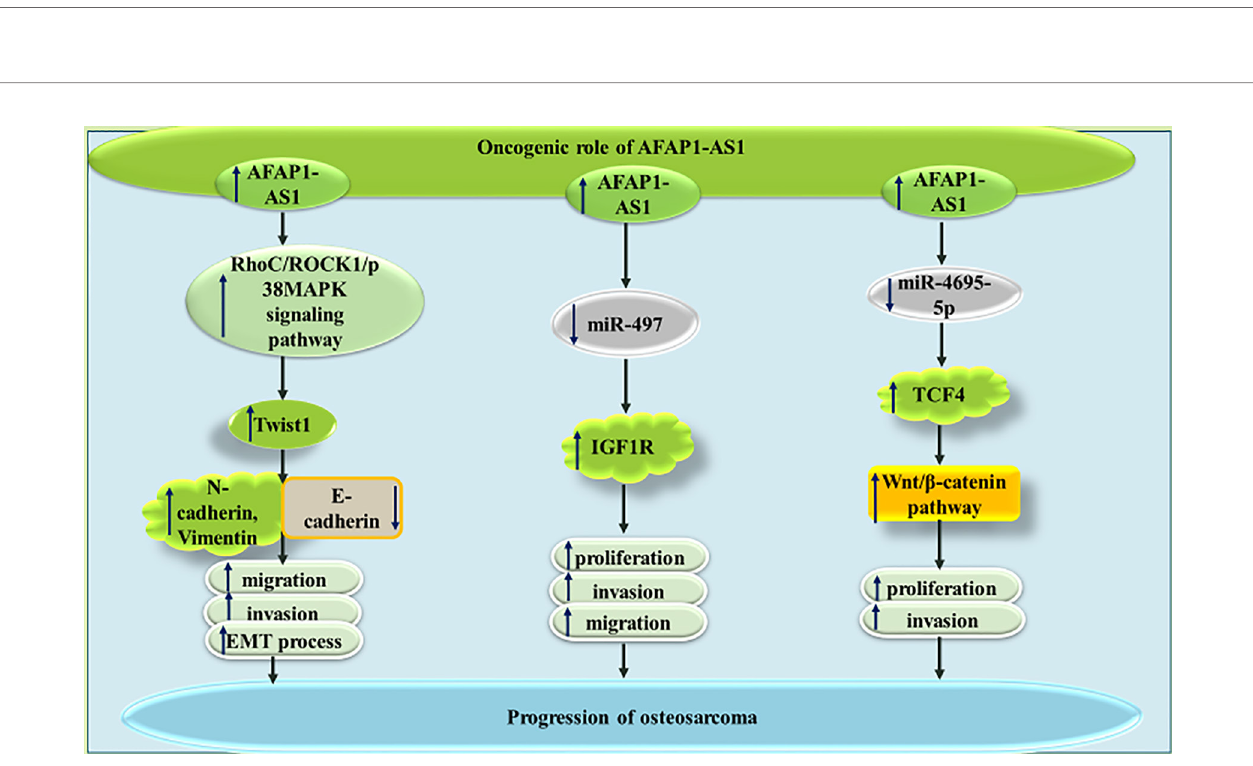
FIGURE 4 | The oncogenic role of AFAP1-AS1 in osteosarcoma is exerted through modulation of RhoC/ROCK1/p38MAPK/Twist1 cascade as well as sponging miR-497 and miR-4695-5p.